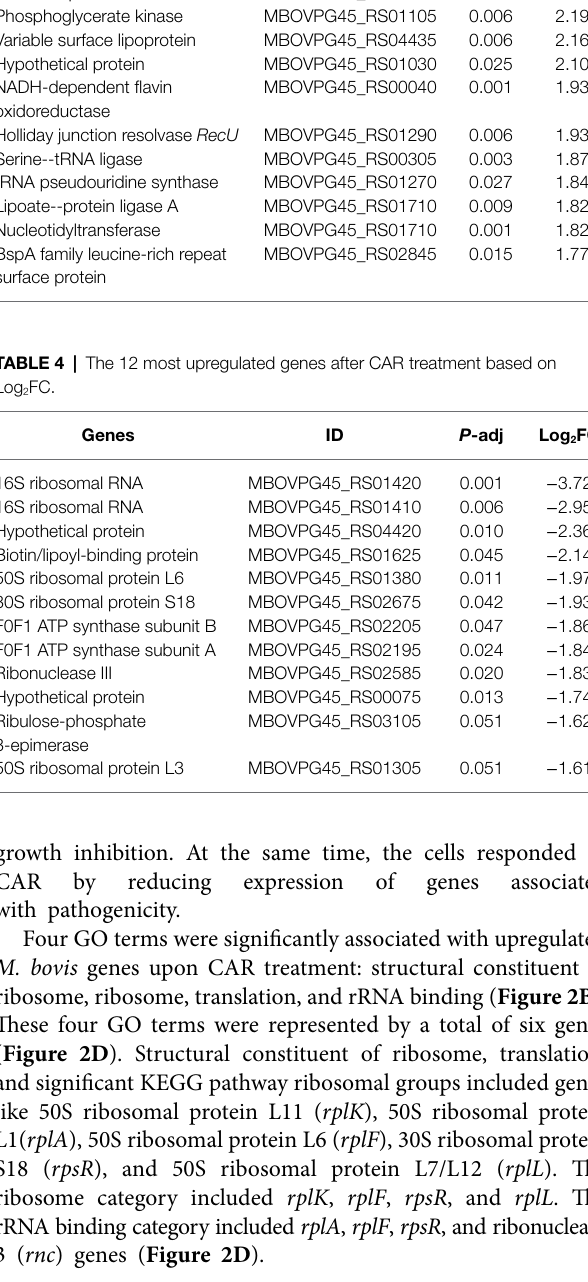
( Figure 2D ). Structural constituent of ribosome, translation, and significant KEGG pathway ribosomal groups included genes like 50S ribosomal protein L11 ( rplK ), 50S ribosomal protein L1( rplA ), 50S ribosomal protein L6 ( rplF ), 30S ribosomal protein S18 ( rpsR ), and 50S ribosomal protein L7/L12 ( rplL ). The ribosome category included rplK , rplF , rpsR , and rplL . The rRNA binding category included rplA , rplF , rpsR , and ribonuclease 3 ( rnc ) genes